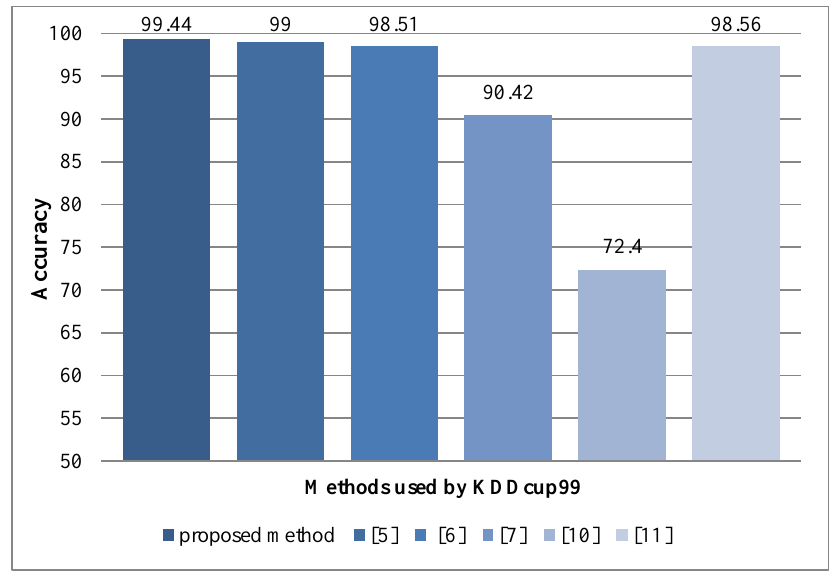
Figure 7. Comparison of the proposed model with other models for the KDD